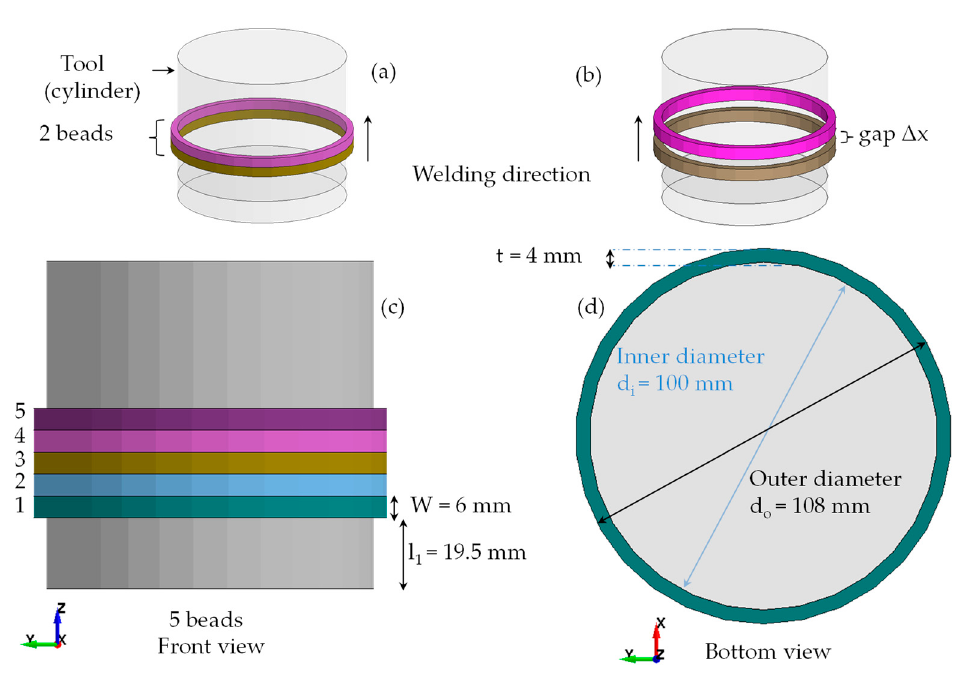
Figure 8. Patterns of two and five parallel beads without a gap ( a , c ), two parallel beads with gap Δ x ( b ), and dimensions of a bead welded on the tool ( d ).